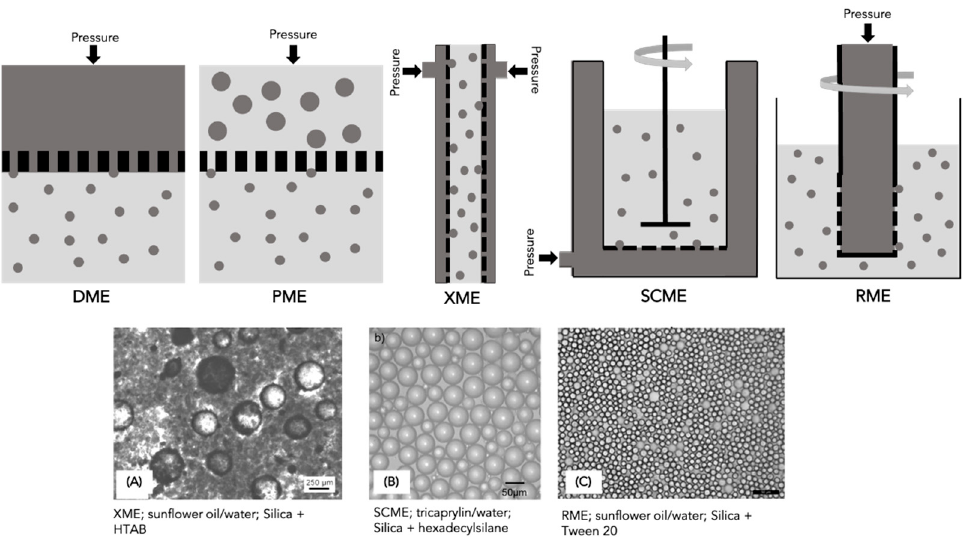
Figure 8. Schematisation of membrane emulsification. DME: direct membrane emulsification; PME: premix membrane emulsification; XME: crossflow membrane emulsification; SCME: stirred-cell membrane emulsification; and RME: rotational membrane emulsification. Some examples of PEs obtained from XME—( A ) [103], SCME—( B ) [97] and RME—( C ) [102]. (Reprinted from [103], Copyright (2016), with permission from Elsevier; Reprinted from [97], Copyright (2017), with permission from the American Chemical Society; Reprinted from [102], Copyright (2019), with permission from Elsevier).